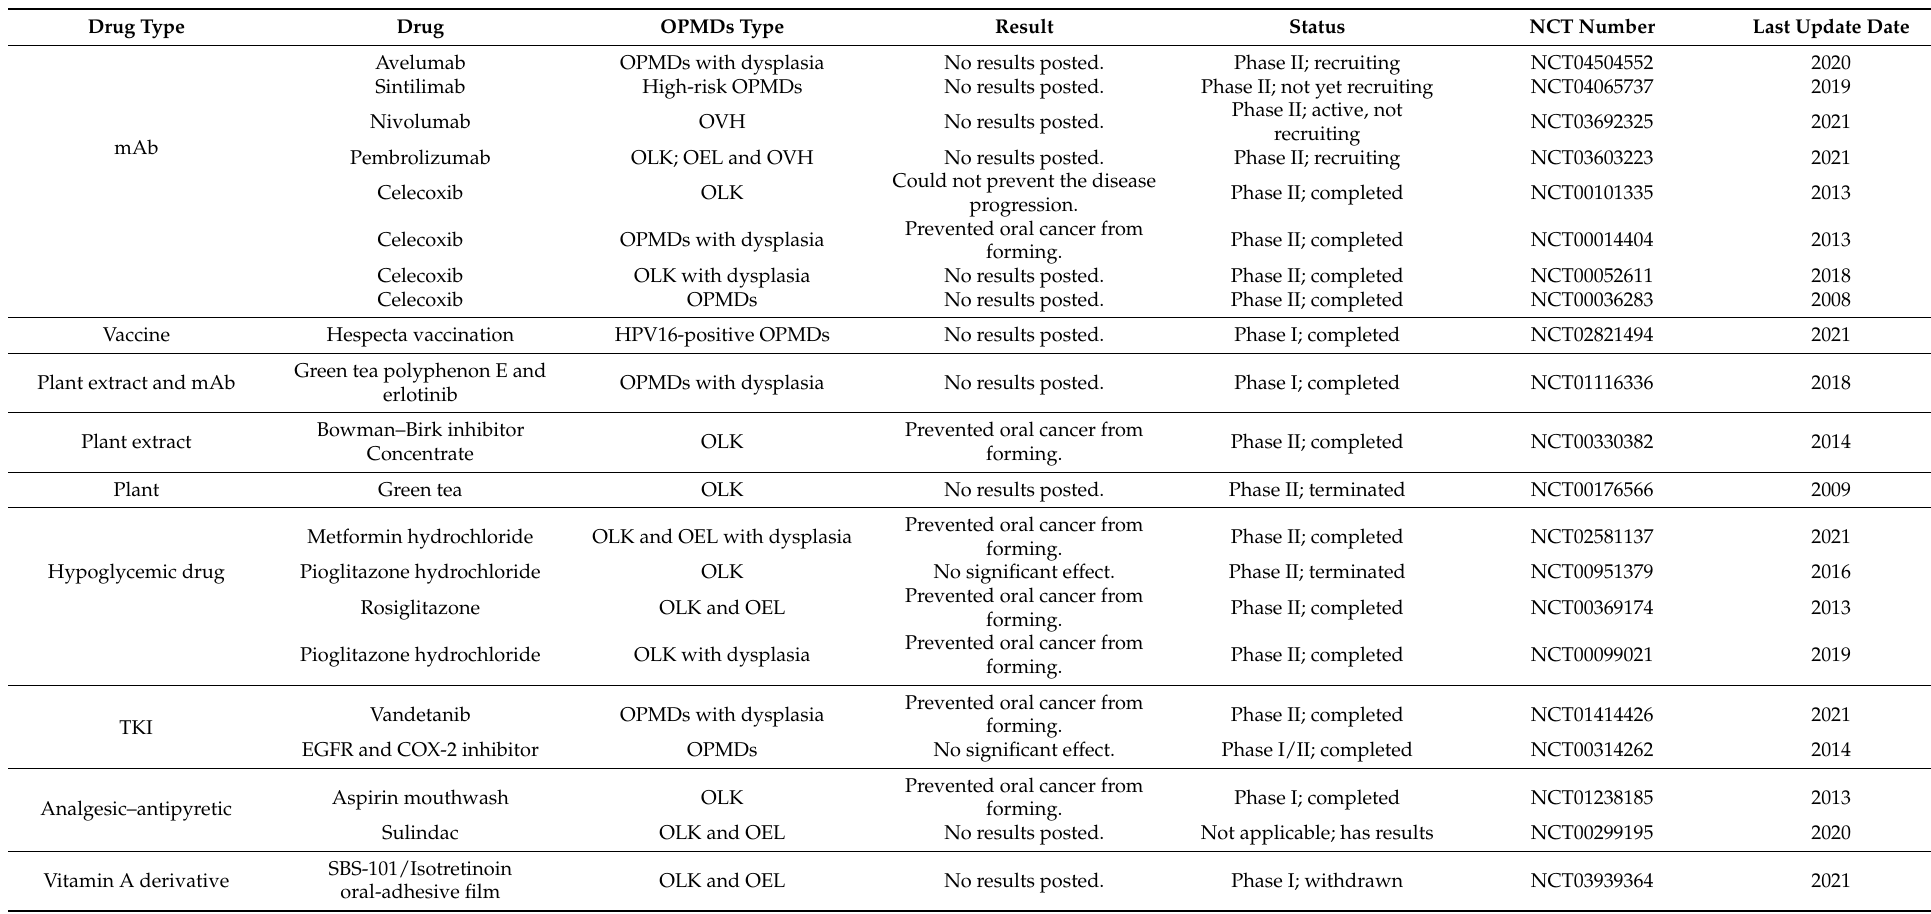
Table 1. Recently completed and ongoing chemoprevention of OPMDs carcinogenesis (data collected from https://clinicaltrials.gov, accessed on 3 June